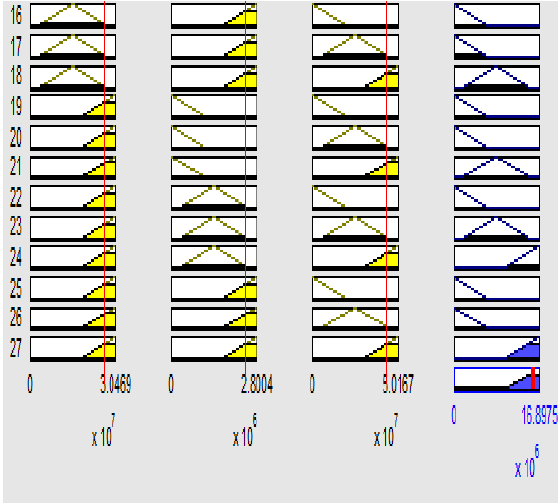
Figure 7. Resolution of Fuzziness – Output Variable (Profit) 5-